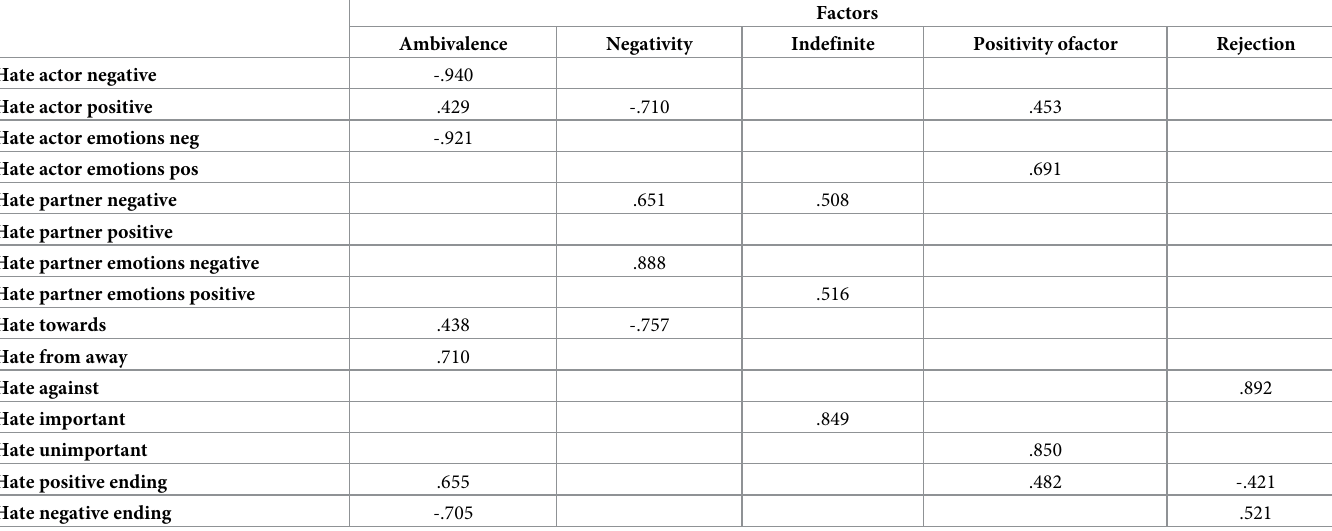
Table 4. Hate: Exploratory factor analysis for narrative indicators ( n =